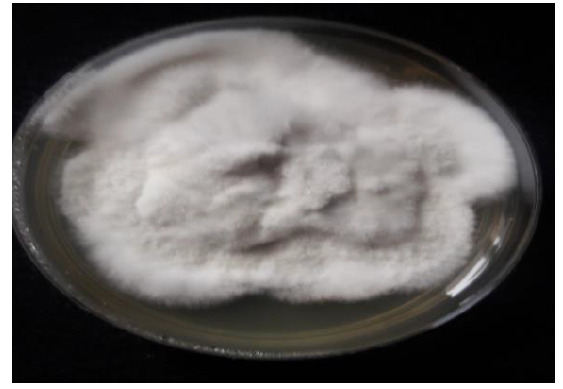
 Colony of Scedosporium apiospermum complex on Sabouraud dextrose agar medium (The colony appearance is cottony and velvety, with the color being changed from white to grey.)